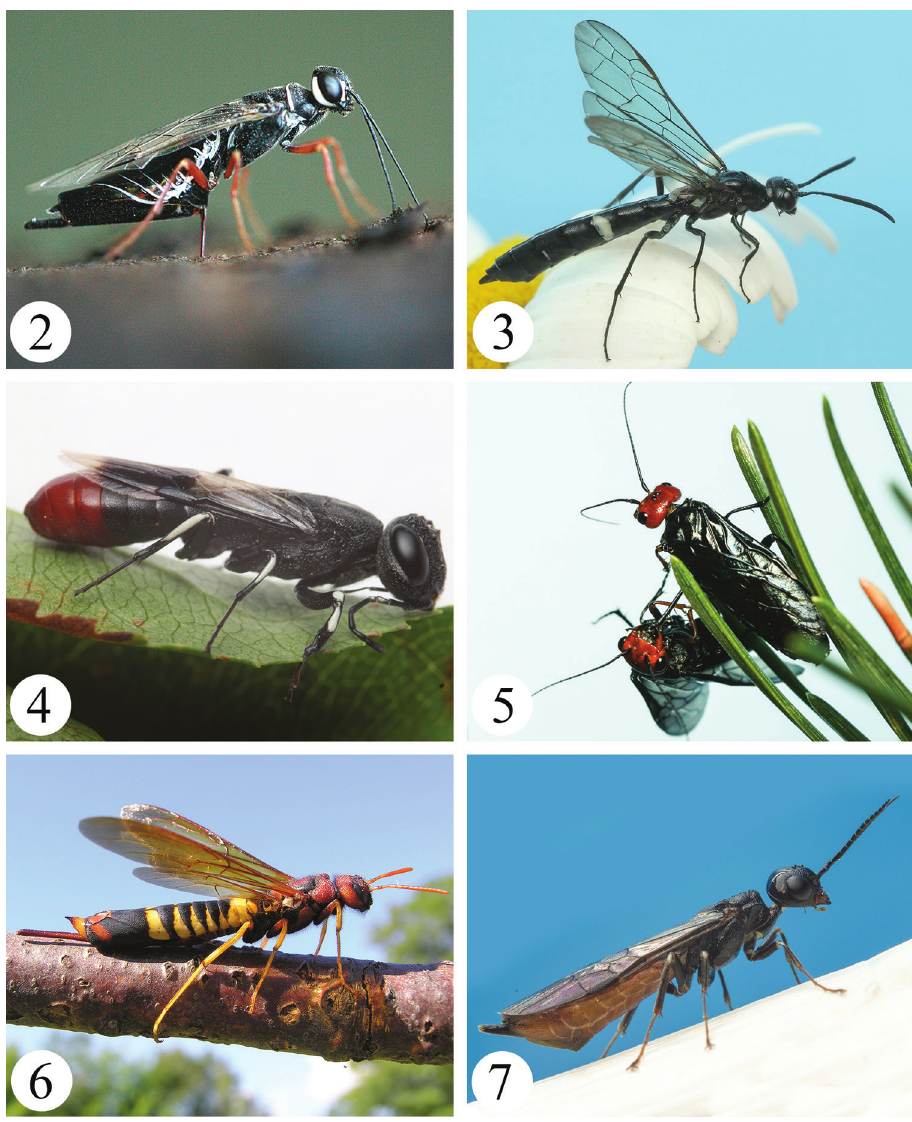
Figures 2–7. Sawfly adults 2 Syntexis libocedrii (Anaxyelidae), Oregon, USA (photo by N. Schiff) 3 Phyl- loecus trimaculatus (Cephidae), Joliette, QC, Canada 4 Orussus occidentalis (Orussidae), Ottawa, ON, Canada 5 Acantholyda erythrocephala (Pamphiliidae), Ottawa, ON, Canada 6 Tremex columba (Siricidae), Lake Manitou, ON, Canada 7 Xiphydria abdominalis (Xiphydriidae), Ottawa, ON, Canada. tainty for several reasons. First, there are four species of Tenthredo Linnaeus that have been omitted because of unpublished research by the senior author that indicates that they